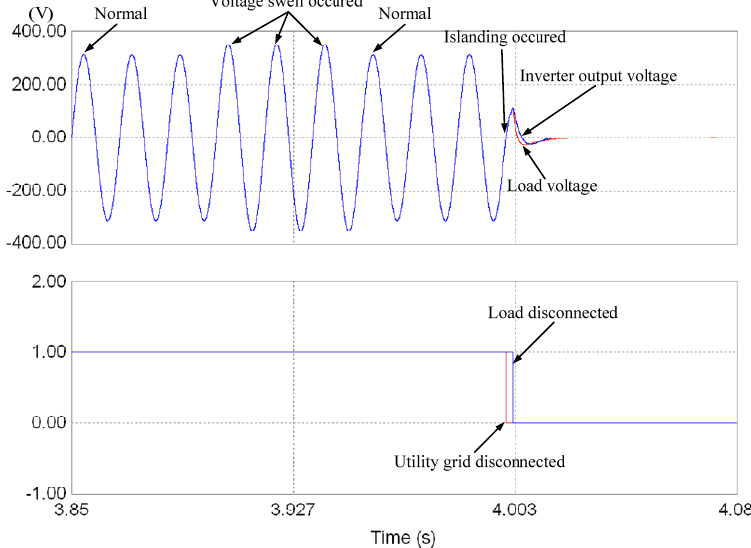
Figure 7. Diagram of simulated islanding detection during voltage